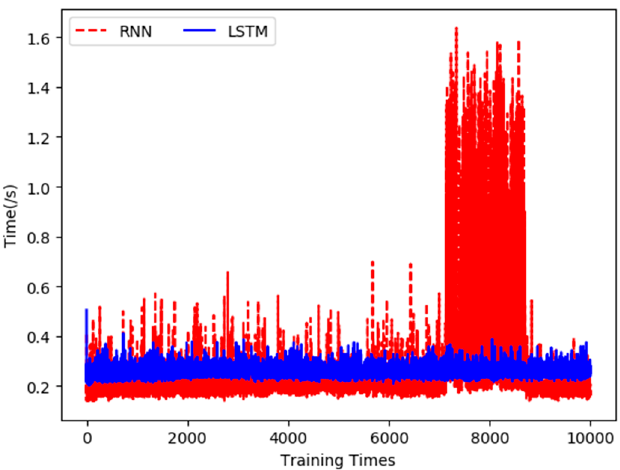
Figure 13. Comparison of training time of water temperature prediction model.